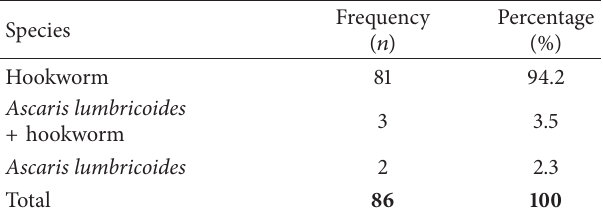
Table 3: Soil-transmitted helminths identified among subjects.